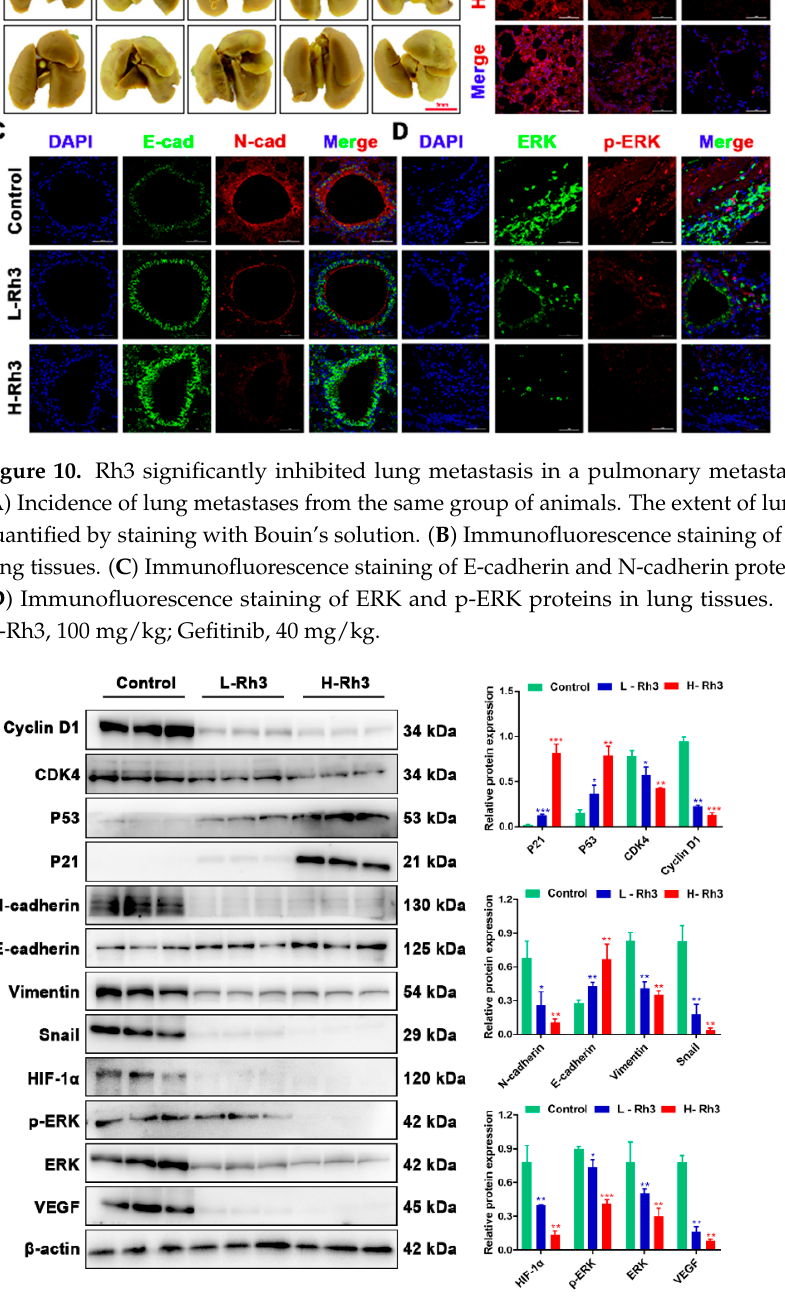
Figure 11. Rh3 blocked the growth of lung cancer in the G1 phase and inhibited the EMT process in the pulmonary metastasis mouse model. Western blotting detection of G1 phase-, EMT-, and ERK-related proteins in lung tissues. Data are presented as means ± standard deviations (SDs). * p < 0.05, ** p < 0.01, *** p < 0.001 compared with control. L-Rh3, 50 mg/kg; H-Rh3, 100 mg/kg; Gefitinib, 40 mg/kg.